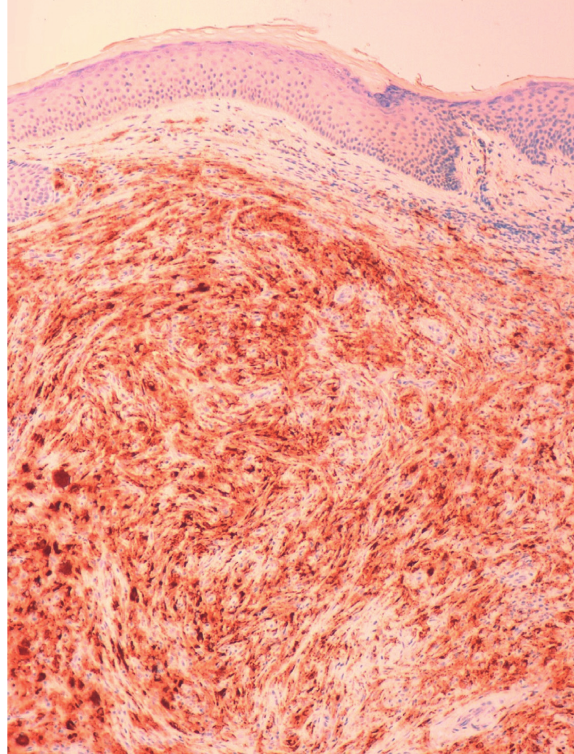
Figure 3: Positivity for histiocytic markers CD 68 ( ×